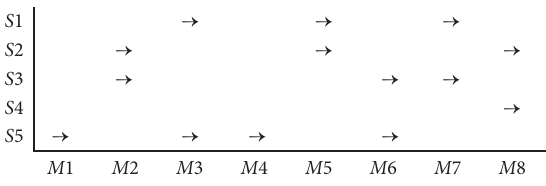
Figure 6: Distribution route of the TS-BPRC